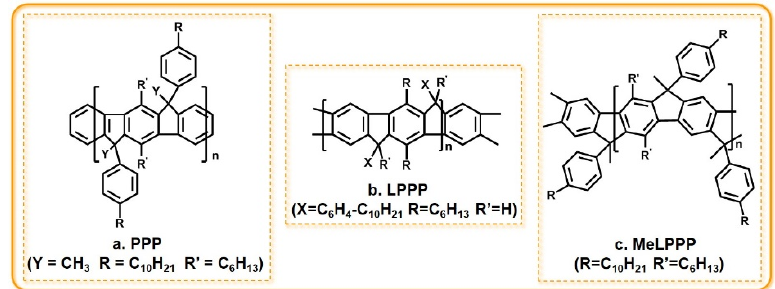
Figure 8. The chemical structure of some PPP derivatives. ( a ) PPP: poly(para-phenylene); ( b ) LPPP: ladder-type poly( p -phyenylene); ( c ) MeLPPP: methyl-substituted ladder-type poly( p -phenylene).